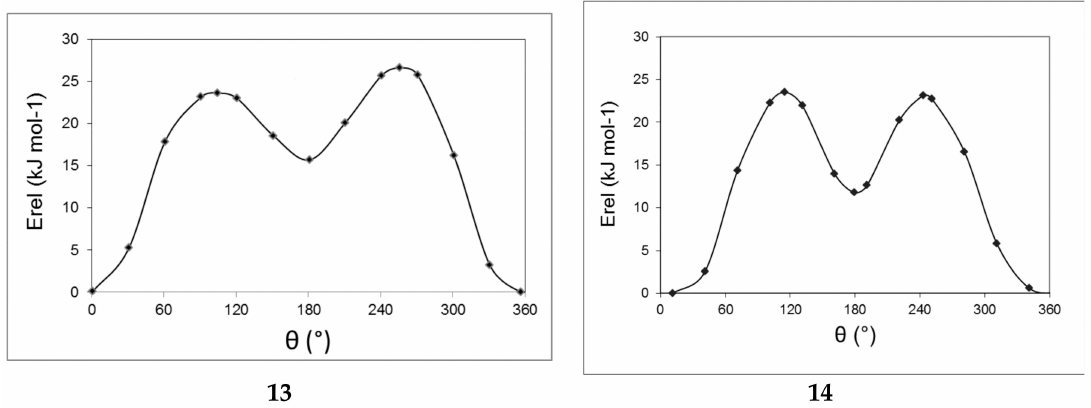
Figure 5. Energy profiles in kJ · mol –1 vs. the dihedral angle θ .